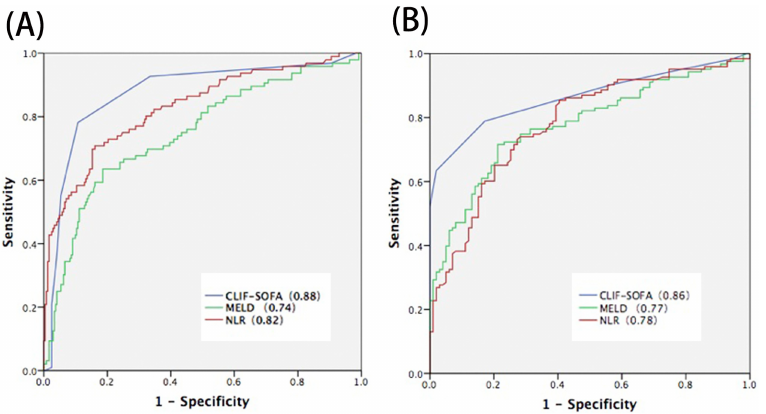
Fig 1. ROC of prognostic variablesfor patients with HBV-ACLF in ALSS (A) and SOC(B) group.